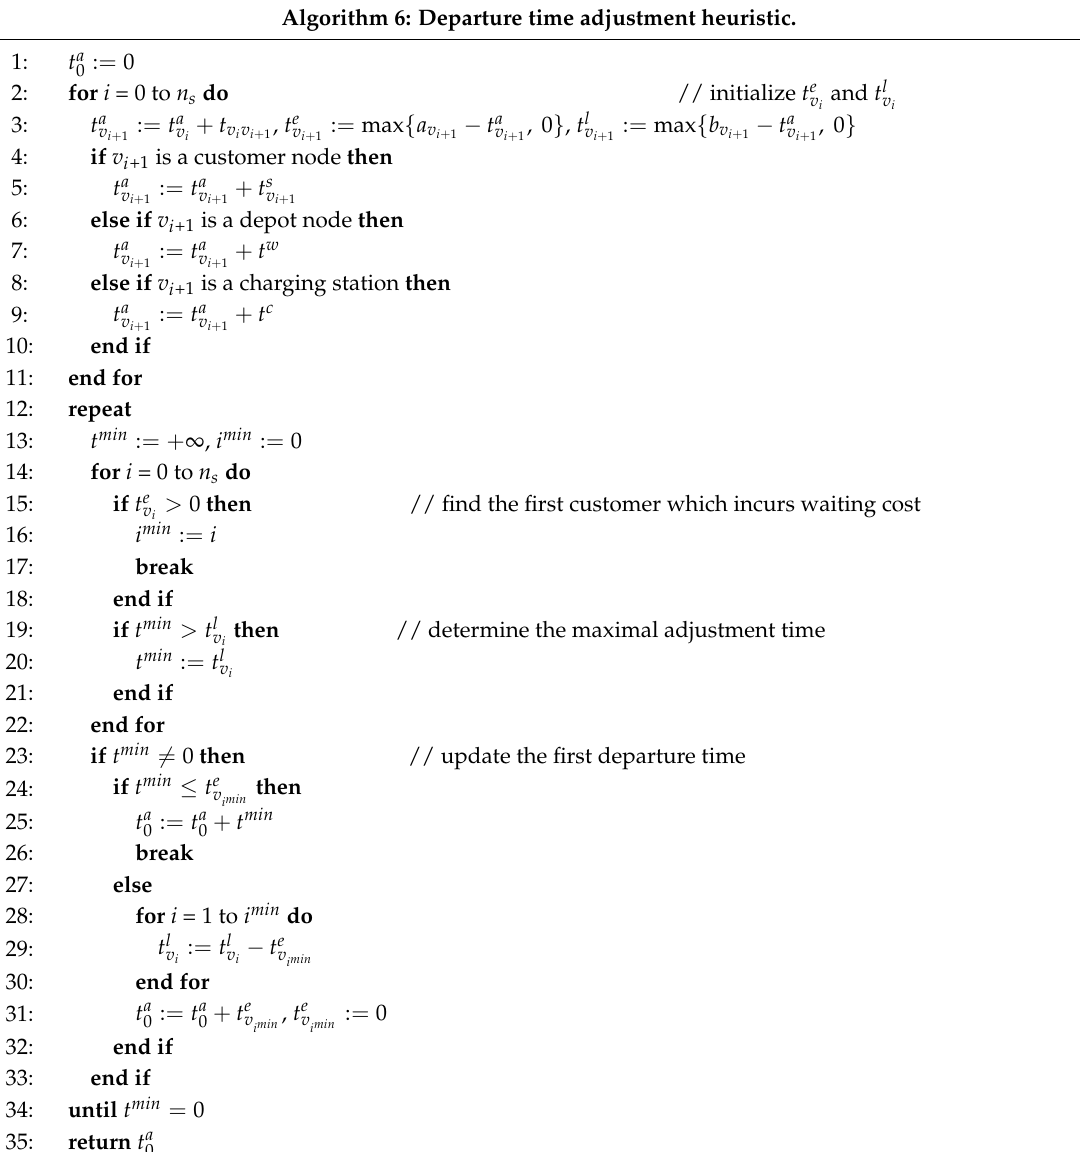
Algorithm 6: Departure time adjustment